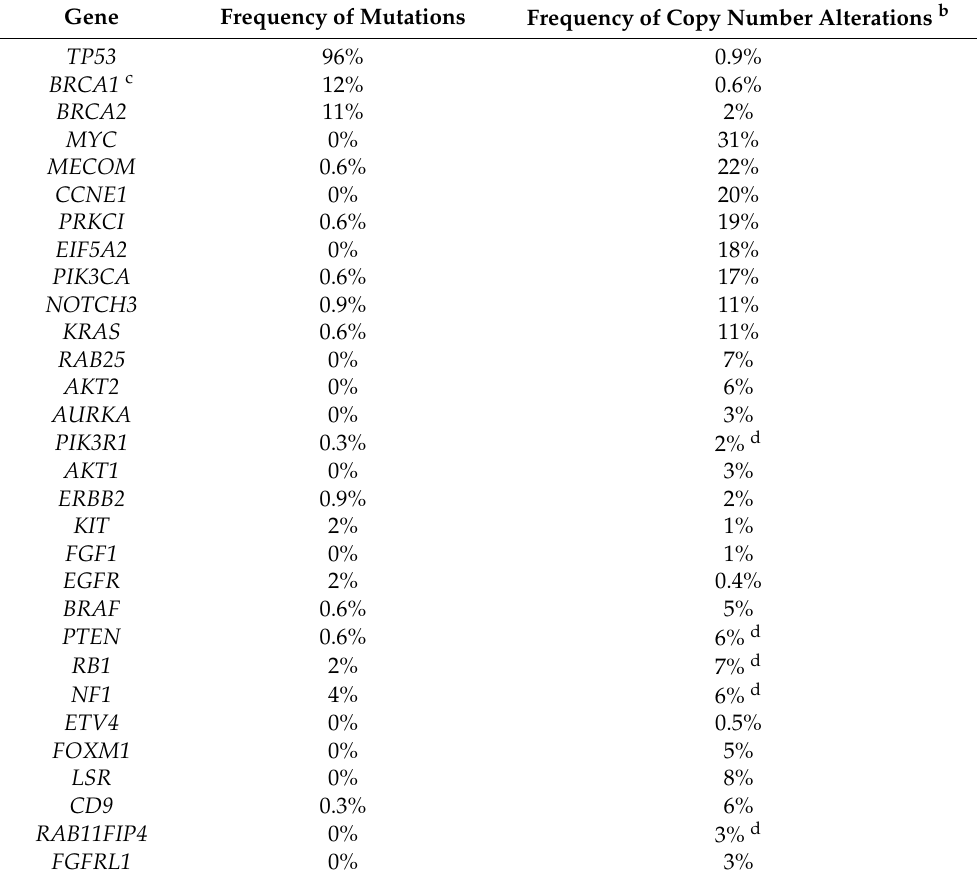
Table 2. Selected genomic alterations and their frequencies in high-grade serous ovarian carcinoma from the TCGA a